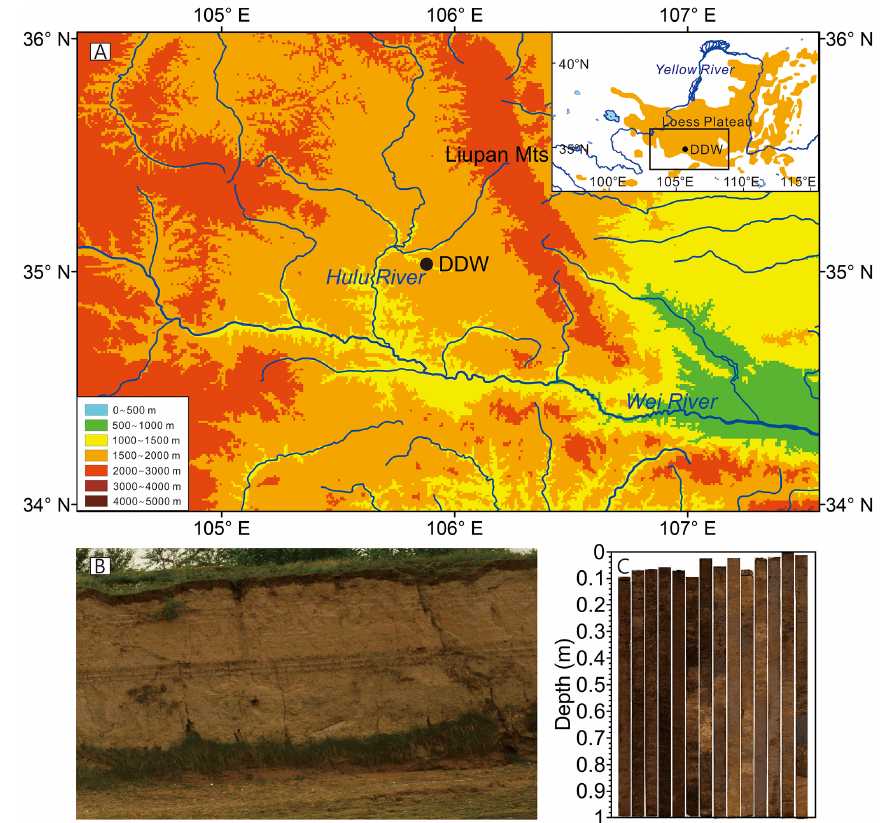
Figure 1. Map showing (a) the CLP and location of the DDW, (b) photographs of DDW terrace outcrop, and (c) cores.